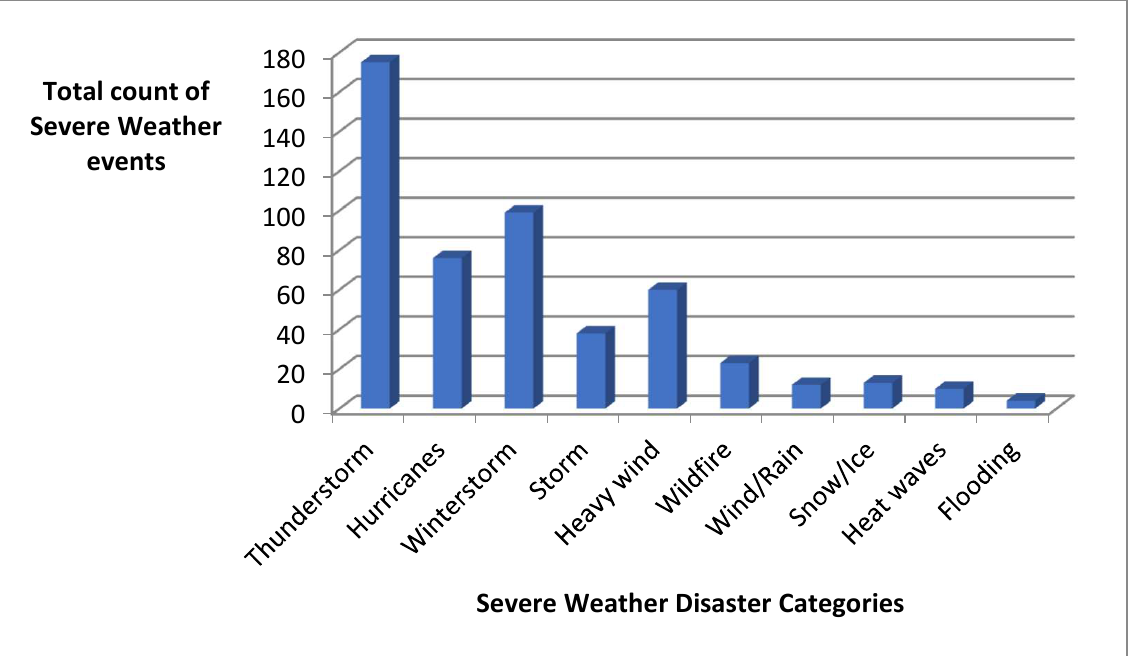
Figure 2. Frequency of different natural disaster events causing power outages.